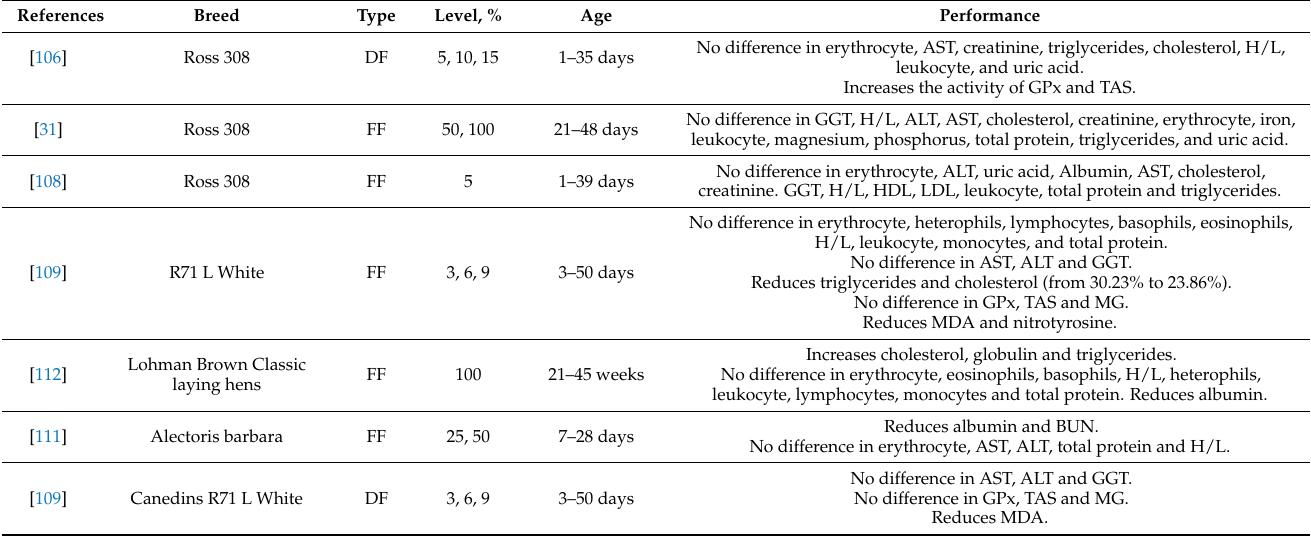
Table 6. Effects of BSFL on the antioxidants and immunity of